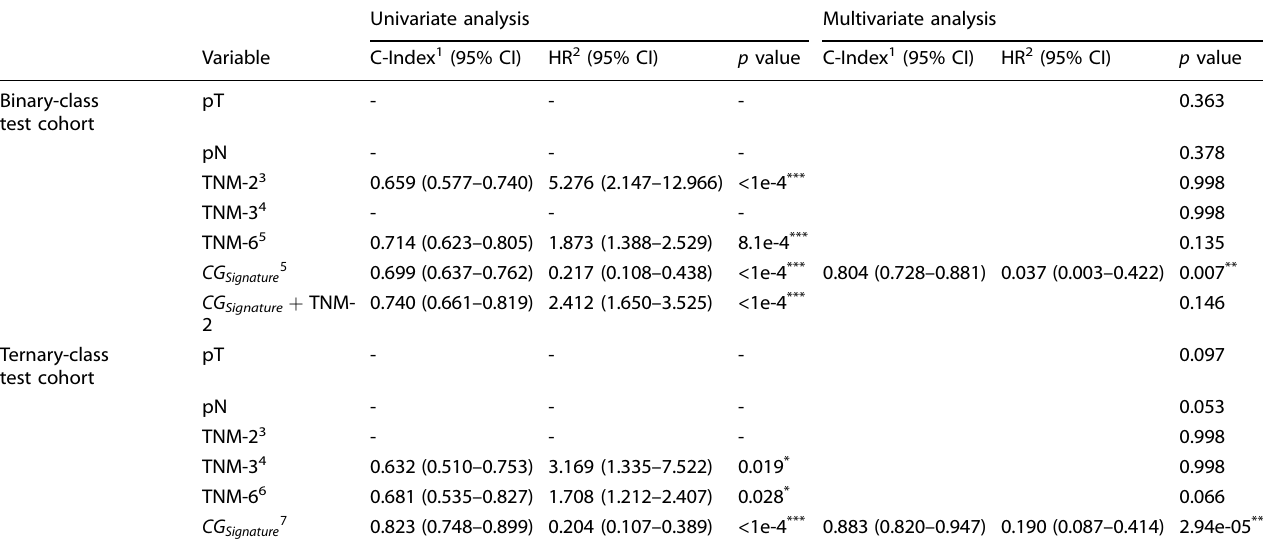
Table 3. Univariate and multivariable Cox regression analysis of overall survival (Cox proportional hazards regression model) based on the predictions of binary- and ternary classi fi cation by CG Signature